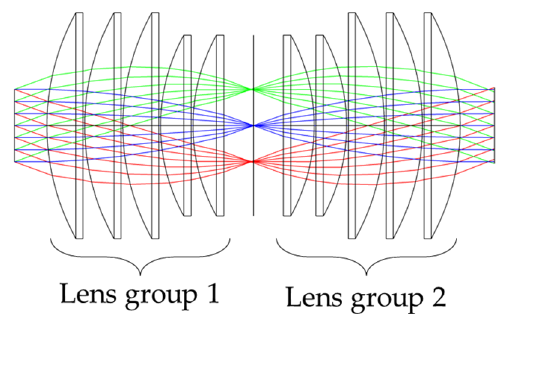
Table 1. Lens parameters of the proposed scanning optics for the dual-axis scanner . Figure 11. Comparison of two high-NA scanning optics based on 4- f structure. ( a ) Conventional configuration with short working distance, and ( b ) proposed configuration with extended working distance via insertion of a concave lens.